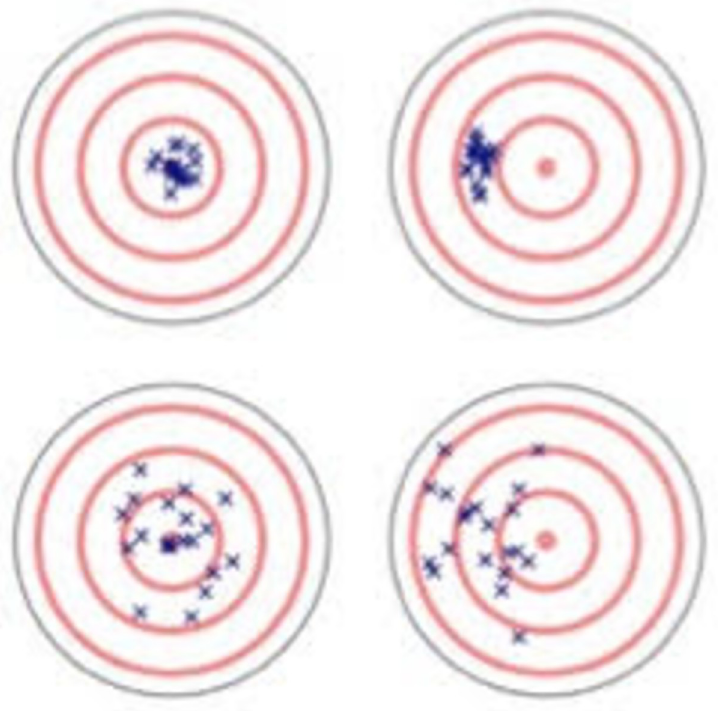
Fig 1. A conceptual illustration of the Calibration and Accuracy PDs. Note . The upper-left panel illustrates an efficient communication of severity of violence (i.e., low Calibration PD and low Accuracy PD) whereas the lower- right panel poor communication (i.e., high Calibration PD and high Accuracy PD). The upper-right panel shows poor calibration but good accuracy, whereas the lower-left panel good calibration but poor